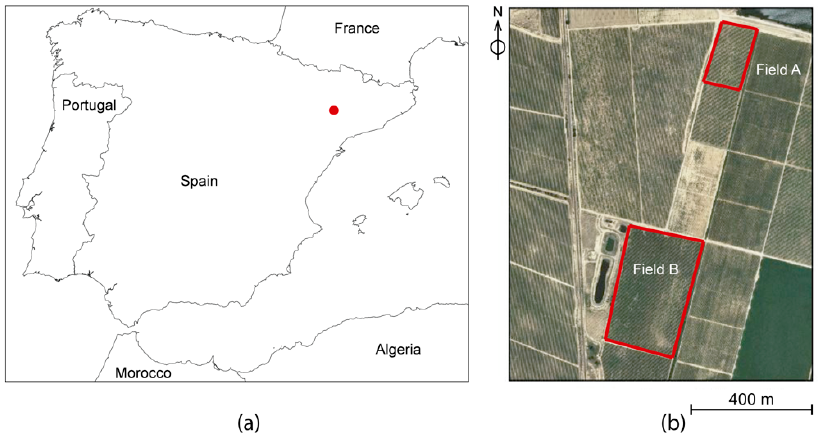
Figure 1. Study area: ( a ) general context and ( b ) locations of